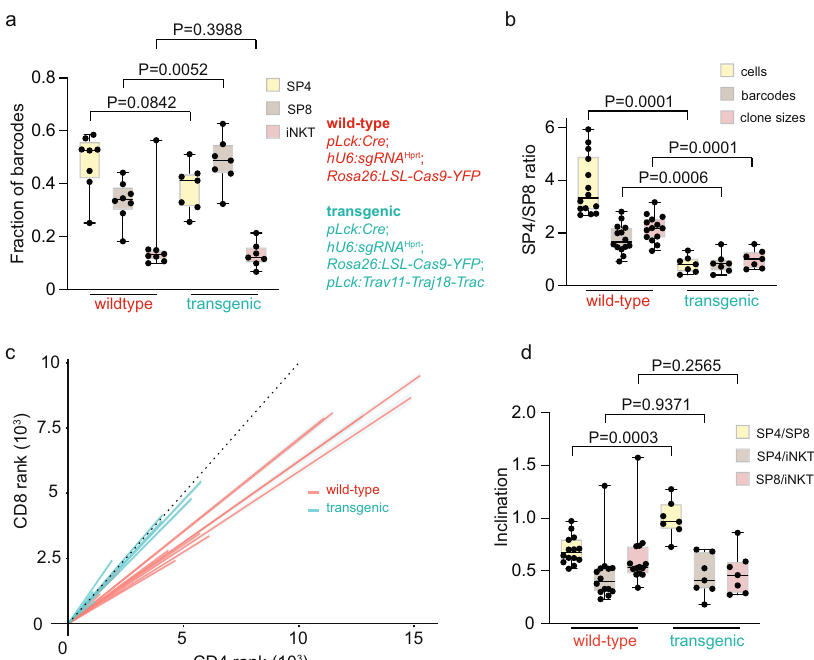
Fig. 6 Loss of CD4-lineage committed thymocytes in pLck:Trav11-Traj18-Trac transgenic mice. a Fractions of barcodes in individual thymocyte populations of the indicated genotypes. Each data point represents one mouse (t-test, two-tailed; pLck:Cre;hU6:sgRNA Hprt ;Rosa26:LSL-Cas9-YFP ( n =